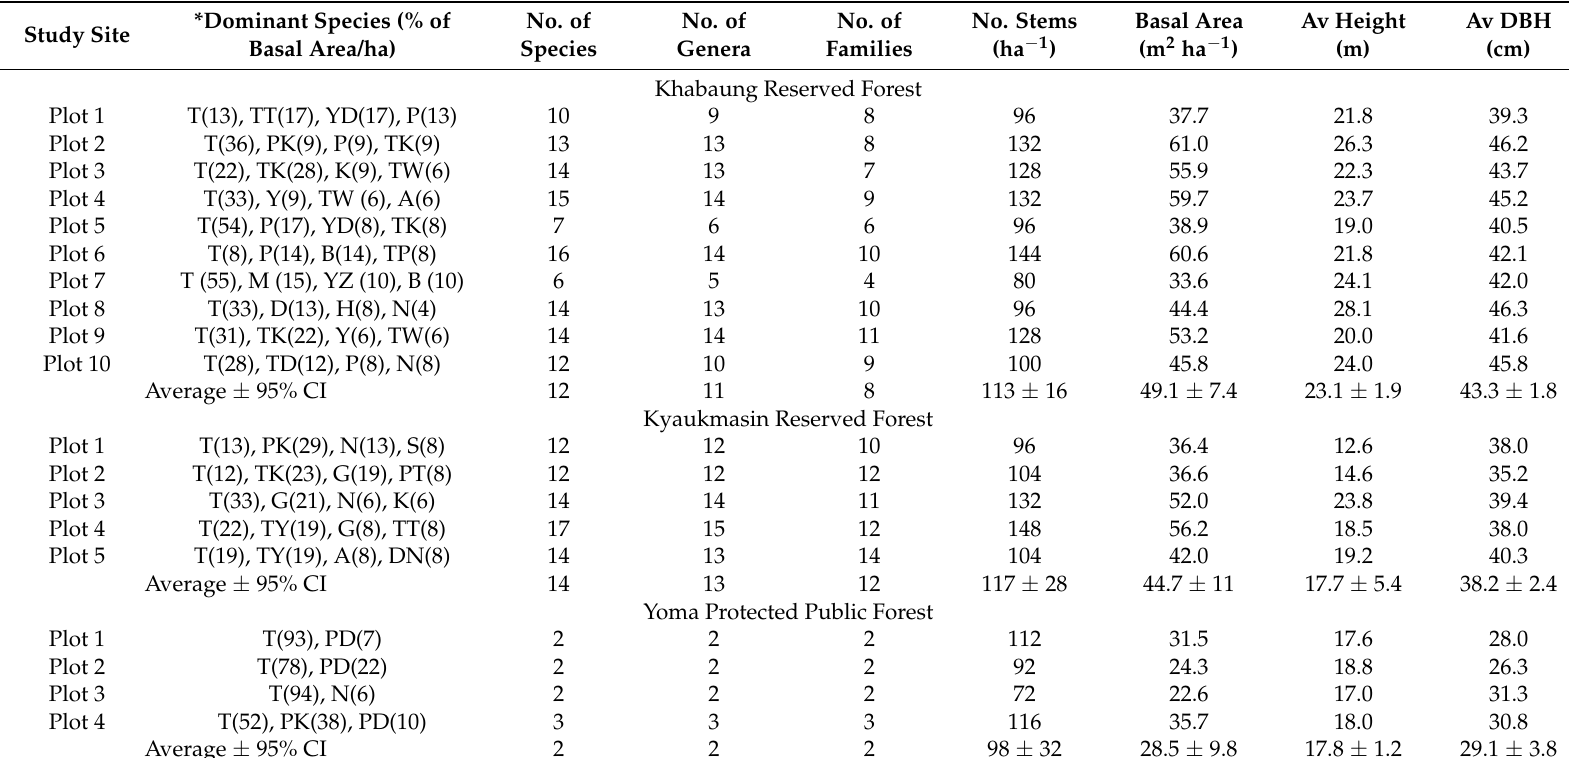
Table 1. Dominant tree species ≥ 20cm DBH (Diameter at Breast Height) and stand characteristics at the study